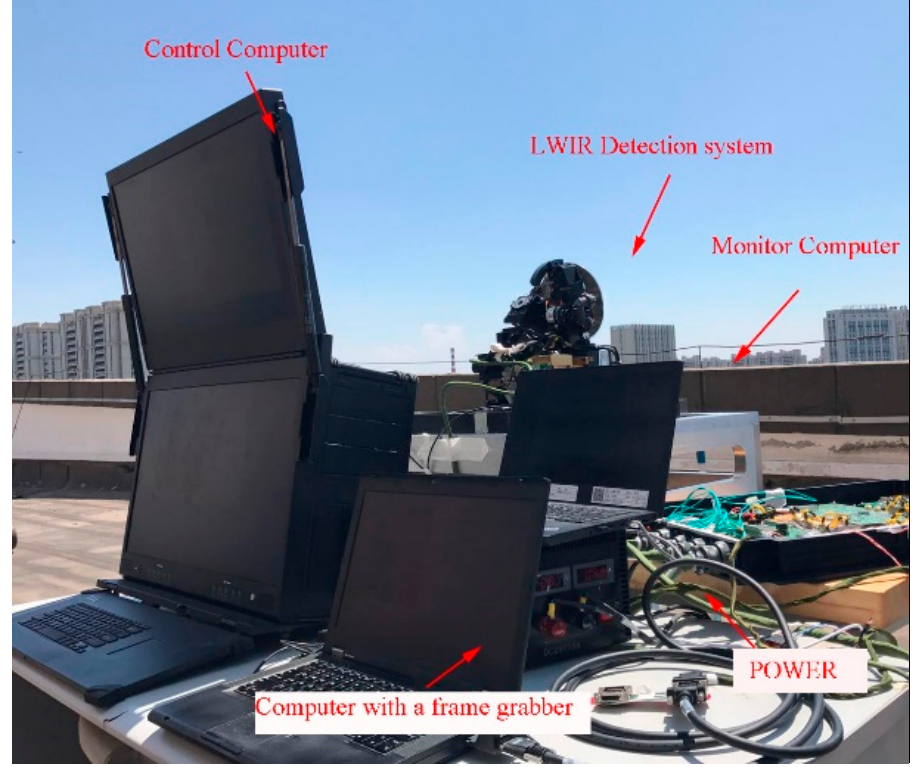
Figure 20. Experimental sky scene with two sets of correction coefficients.